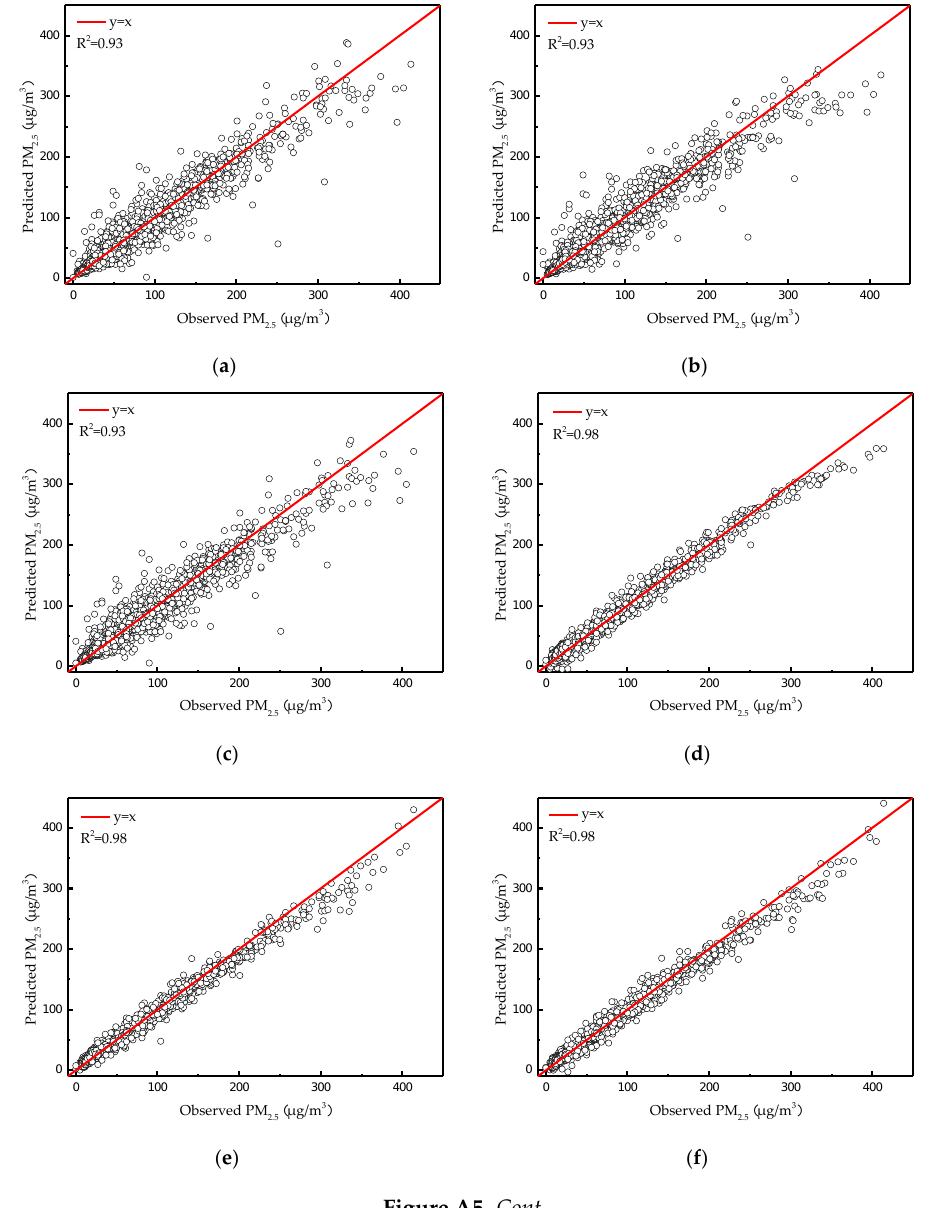
Figure A4. The results of all models in the 19-h PM 2.5 prediction: ( a ) SVR, RFR, and MLP; ( b ) simple RNN, LSTM, CNN–LSTM, and AC-LSTM.